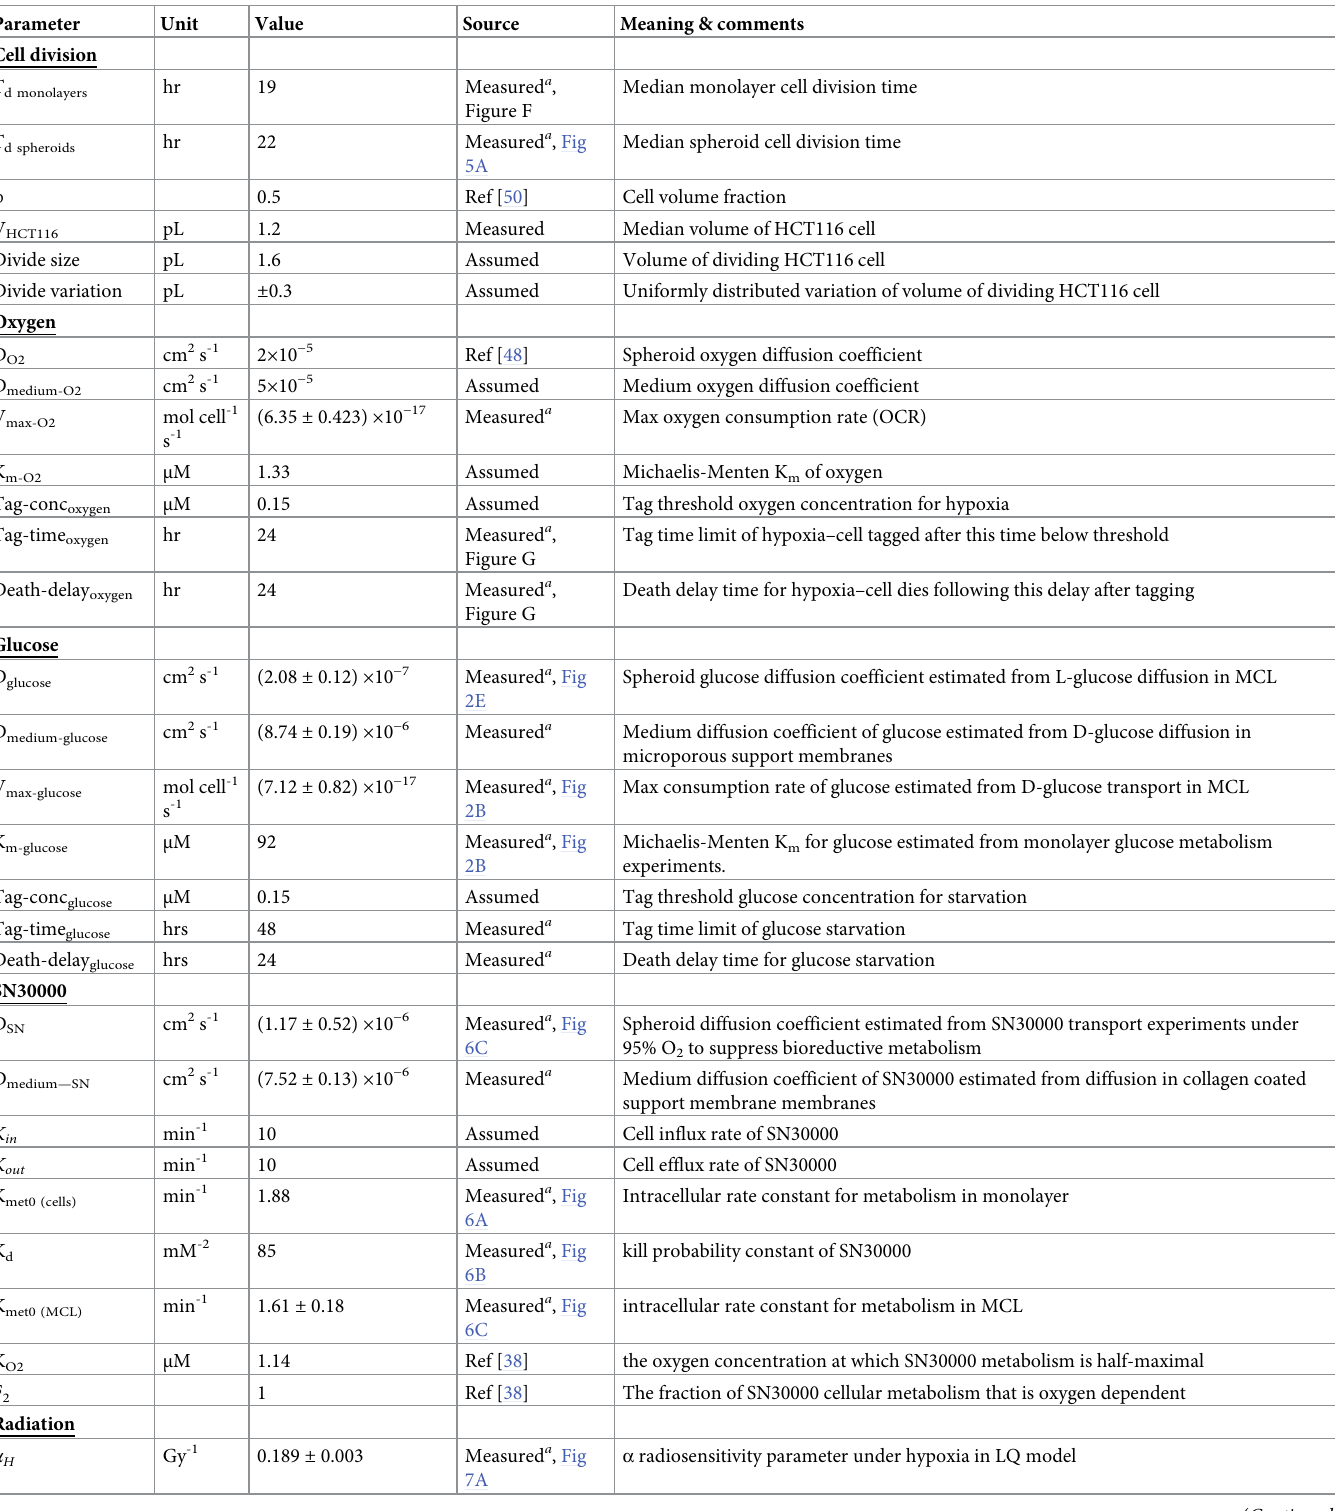
Table 1. Key parameters in the ABM. The parameters used in the ABM are summarized here, including parameter name (units), value and source (either from literature, assumption, or measurement from experiment). Parameter Unit Value Source Meaning & comments Measured a , Median monolayer cell division Figure F